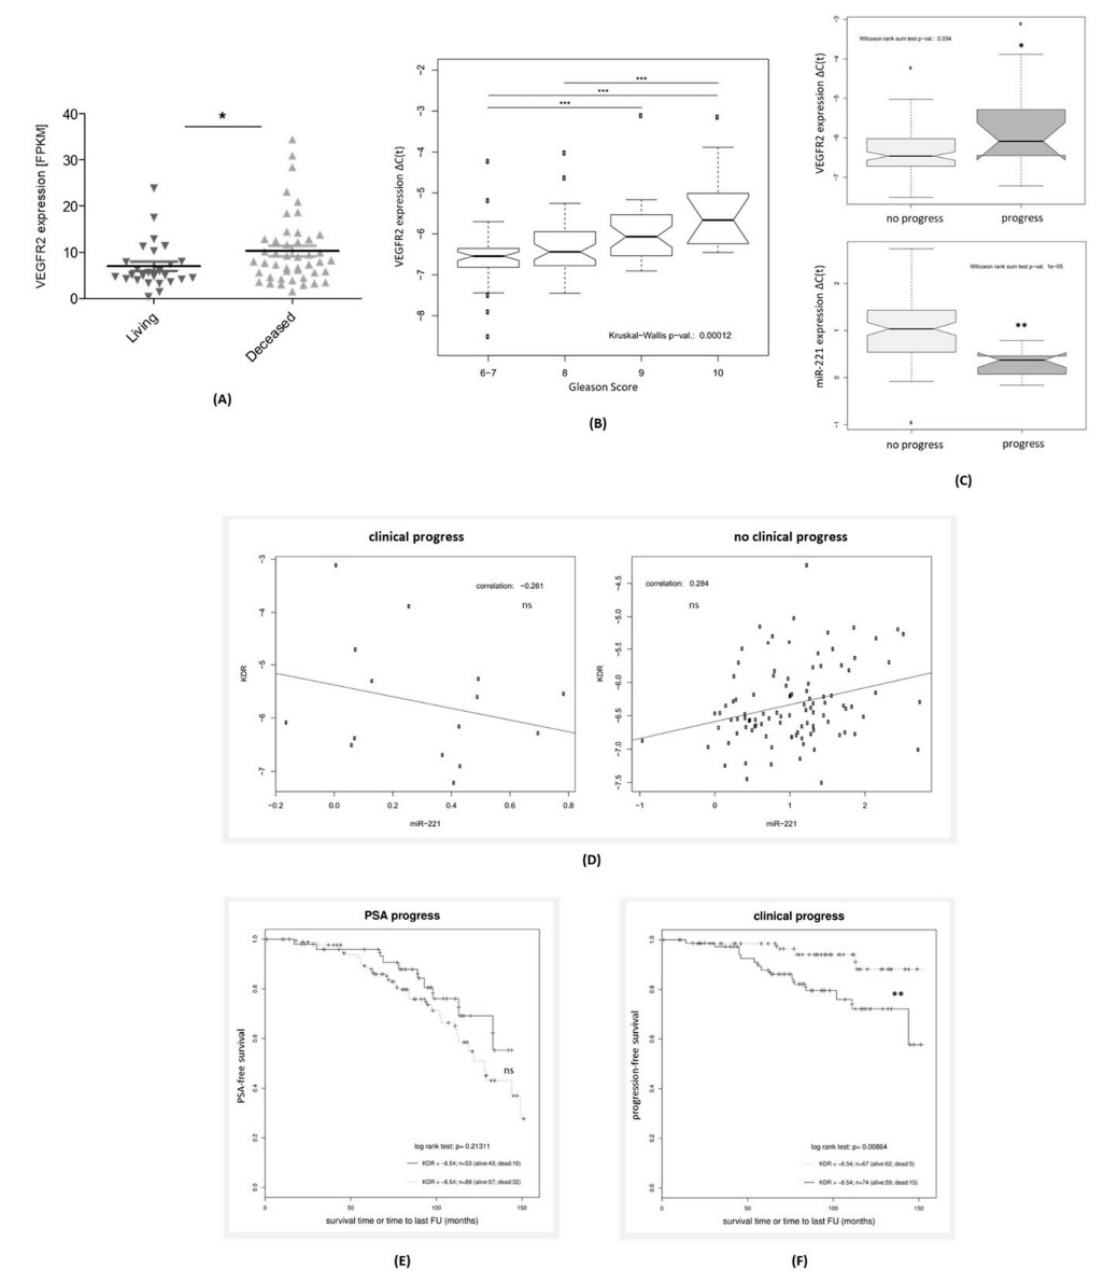
Figure 2. Relative upregulation of VEGFR2 in the Dream Team database of metastatic PCa and our in-house high-risk PCa cohort. ( A ) Significant upregulation of VEGFR2 expression within PCa metastases from patients deceased within the follow-up period (Dream Team database, accessed via cbioportal.org). ( B ) Significant rise of VEGFR2 expression in radical prostatectomy (RP) specimen with higher Gleason Scores in an in-house high-risk PCa cohort ( n = 142). ( C ) VEGFR2 and miR-221 expression in PCa tissue according to the endpoint of clinical progress. ( D ) Pearson correlation coe ffi cients for miR-221 and VEGFR2 expression in high-risk PCa specimen depending on progression. ( E , F ) Kaplan Meier plots of VEGFR2 expression for PSA progress ( E ) and Clinical progress ( F ). (A–F) ns: not significant. *: p < 0.05. **: p < 0.01. ***: p <